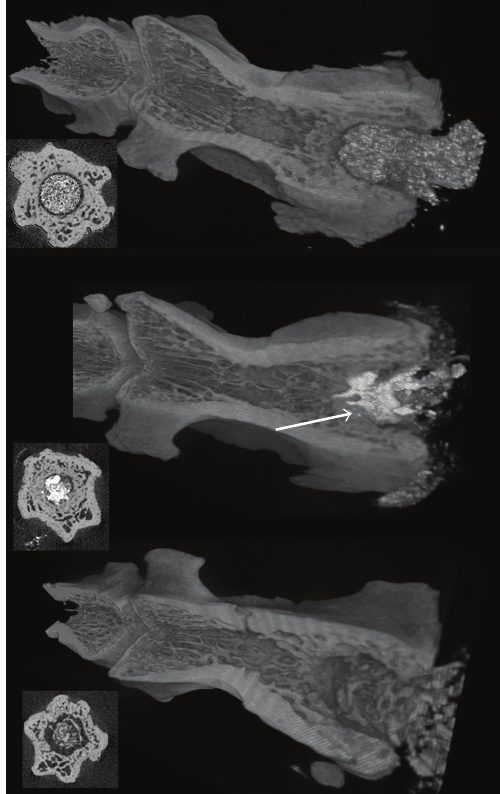
Figure 6: The representative micro-CT images after 12 weeks of the operated vertebra. PMMA (upper image) is compacted in the hole, but no bone formationwas observed; a radiolucent area is seen between the PMMA and the bone. The pCPC (middle image) is slowly resorbed, and new bone is formed in connection with the pCPC (arrow). There was some bone formation around the bone chips, however considerable radiolucent areas can also be observed.